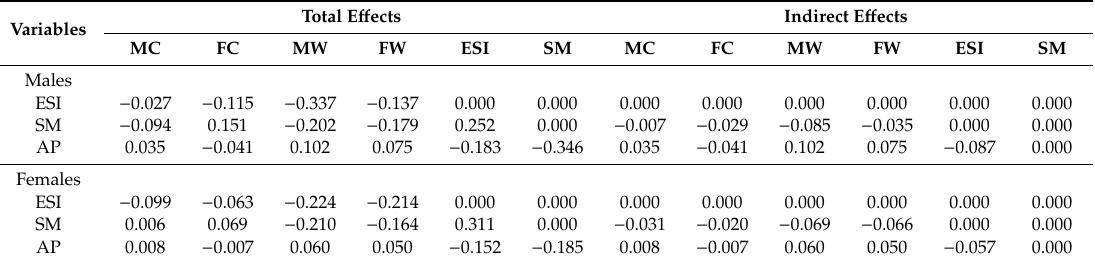
Table 5. Standardized total and indirect e ff ects of the model by